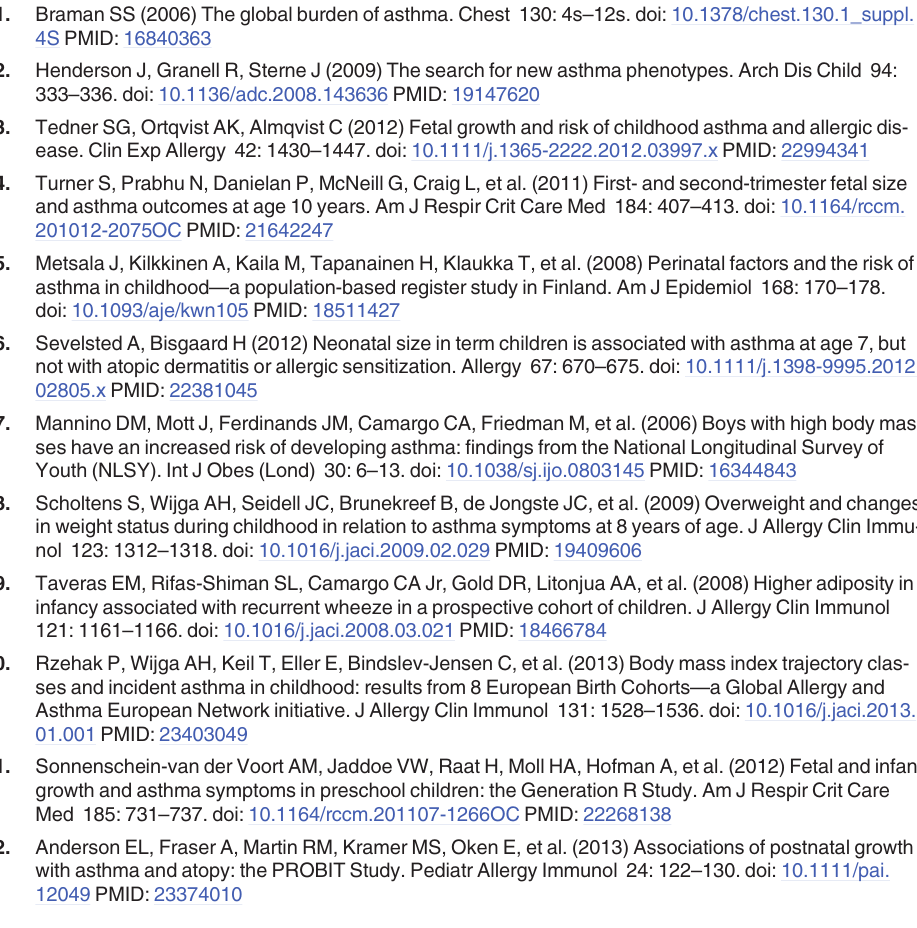
S1 Fig. Directed acyclic graph. Child characteristics: child gender and breastfeeding the first 6 months. Maternal characteristics: maternal age, maternal education, maternal salary, mater- nal parity, maternal smoking during pregnancy and maternal folate intake during pregnancy. Genes: Genetic predisposition for growth and asthma. Measured by maternal height, maternal body mass index, paternal height and paternal body mass index, in addition to maternal and paternal history of asthma.